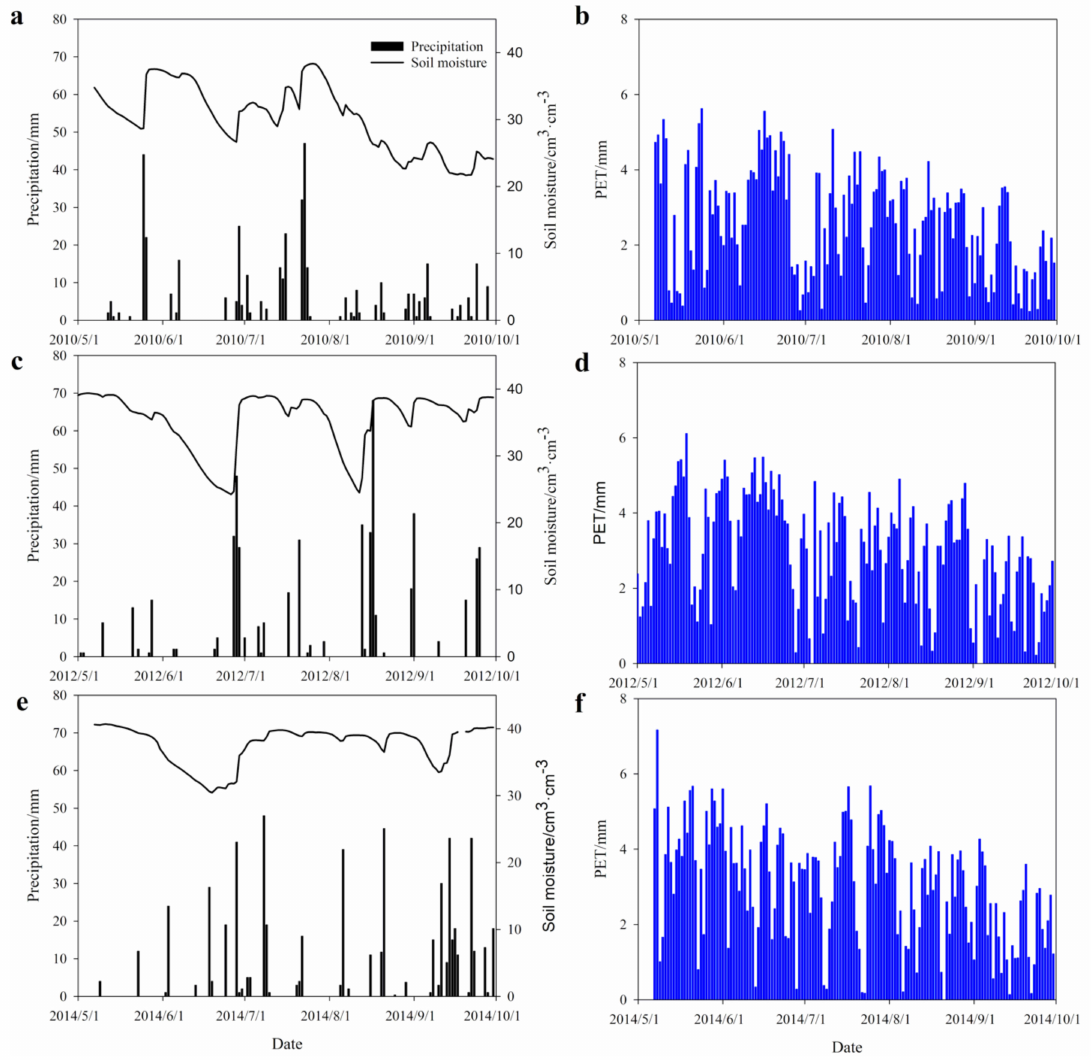
Figure 2. Variations in the daily precipitation (vertical black bars), volumetric soil moisture of the 0–60 cm layer (solid black line), and potential evapotranspiration (PET, vertical blue bars) during the growing season of 2010 ( a , b ), 2012 ( c , d ), and 2014 ( e , f